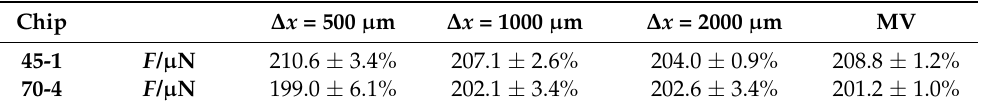
Table 9. Mean values of the stylus force F determined by the difference method from the last 1000 µ m of the measured profiles using cantilevers of different thickness.